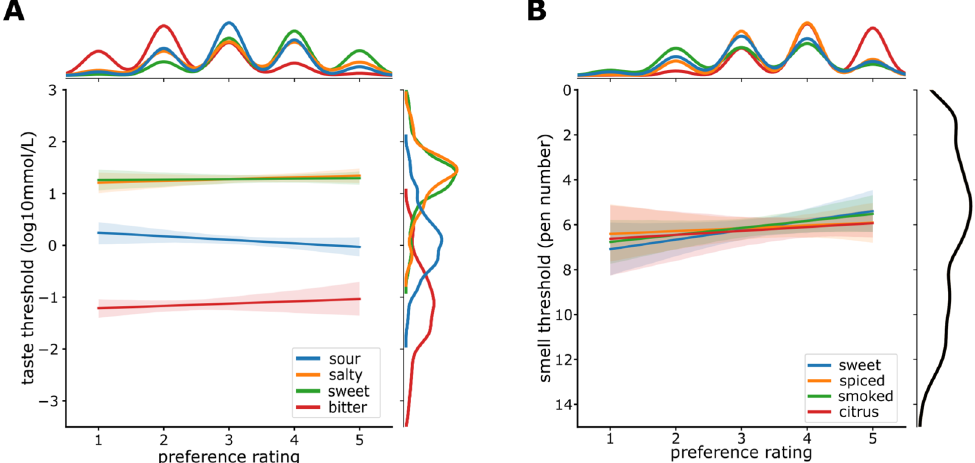
Figure 4. ( A ) Scatter plot with linear fit for taste threshold for different taste qualities and their corresponding taste preference rating. Colors indicate taste qualities. ( B ) Scatter plot with linear fit for rose smell threshold and preference ratings for four odor qualities. Colors indicate odor qualities. Shaded regions show 95% CI (confidence interval). Density functions for preference ratings are plotted at the top and for taste/smell thresholds on the right of each figure.